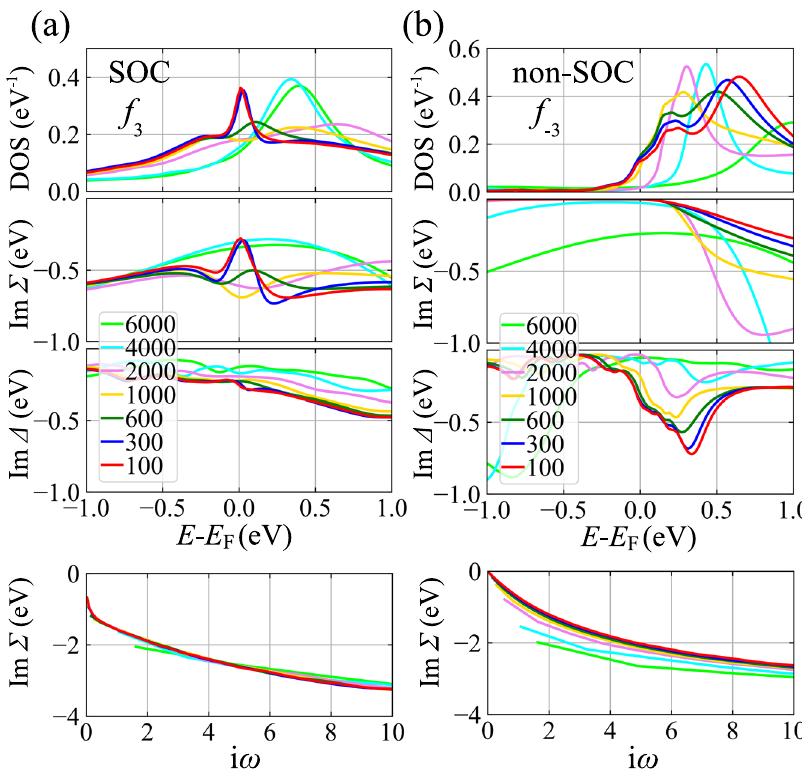
Fig. 5 Evolution of electronic structure. Calculated density of states, the imaginary part of the self-energy and hybridization function of ( a ) f 3 in SOC and ( b ) f − 3 in non-SOC system. The simulation temperature unit is K. The zero of energy is set at the Fermi level. Lower panels in ( a ) and ( b ) show imaginary part of the self-energy on the imaginary frequency